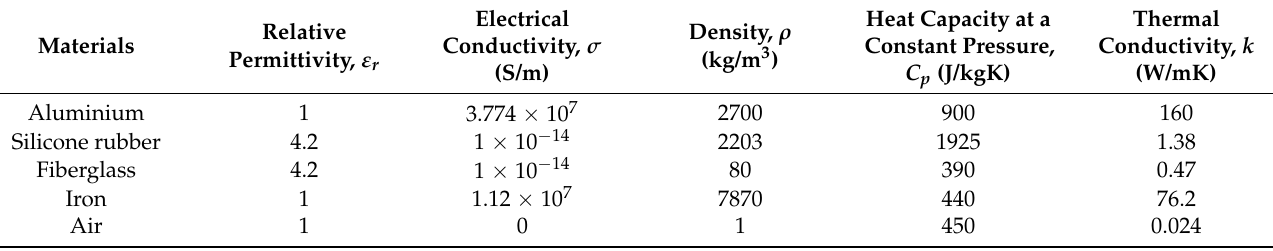
Figure 2. Dimensions of corona ring. Table 2. Material properties for each part in the model.